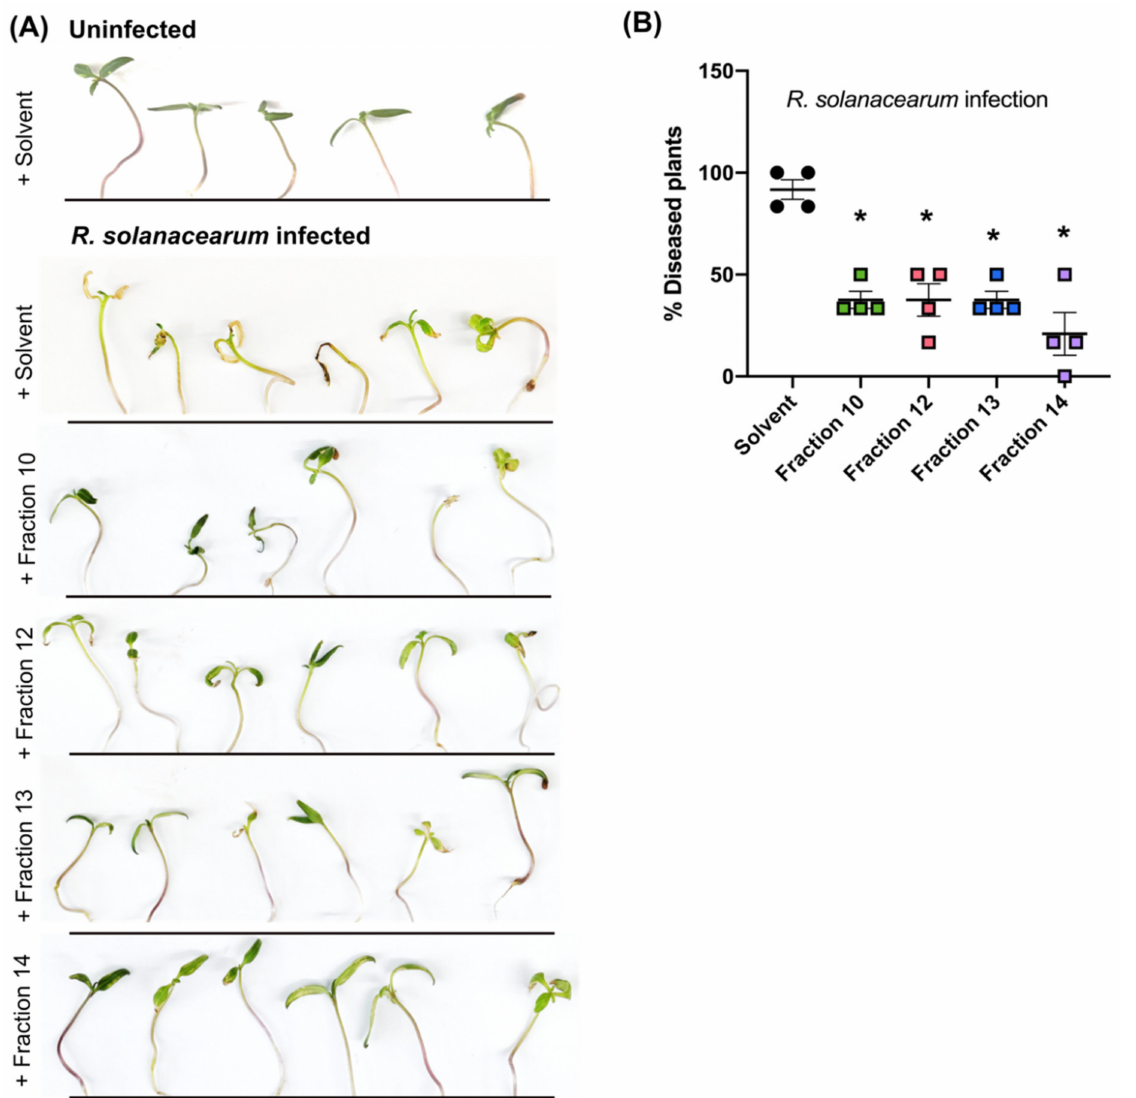
Figure 5. Secondary metabolites from co-infection secretome protect tomato seedlings from R. solanaceaum wilt. ( A ) 11-day old seedlings were infected with R. solanacearum after which either 80% acetonitrile (solvent control) or fractions of the ethyl acetate crude extract were applied to the roots at a final concentration of 1% by volume in water. The top panel shows an uninfected control for reference. The plants were photographed 6 dpi. ( B ) Four individuals scored each plant as to whether they were infected or not. The % diseased plants reported by each person is shown in the graph. ANOVA p < 0.0001. Bonferroni correction was performed to compare disease between solvent and fractions. In all cases, * p <